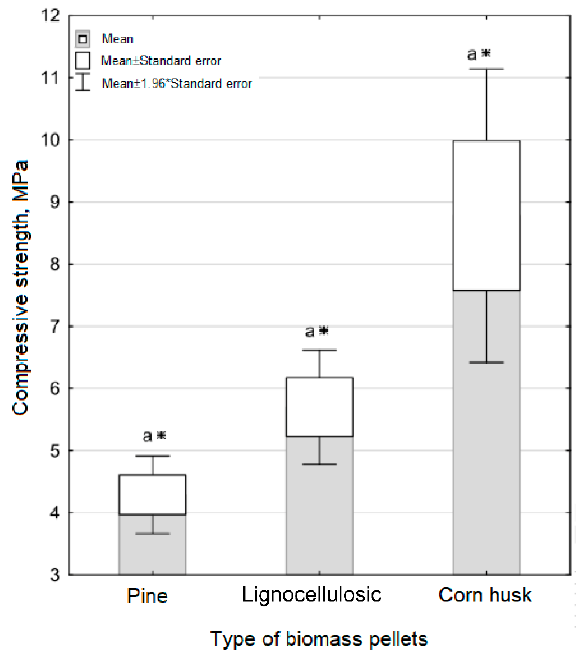
Figure 6. The compressive strength of pellets made of pine, lignocellulosic biomass, and corn husk—letter markings ‘a–e’ signify statistically significant ( p < 0.05) differences between samples of pellets from plant biomass, geometrical markings indicate statistically significant ( p < 0.05) differences between combinations I, II and III.